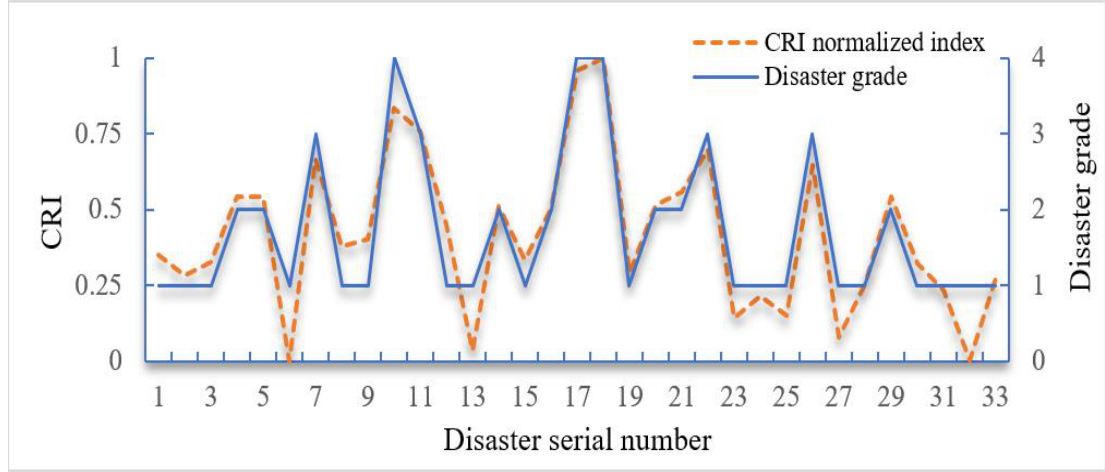
Figure 2. Comparative analysis of CRI evaluated severity and actual disaster severity.